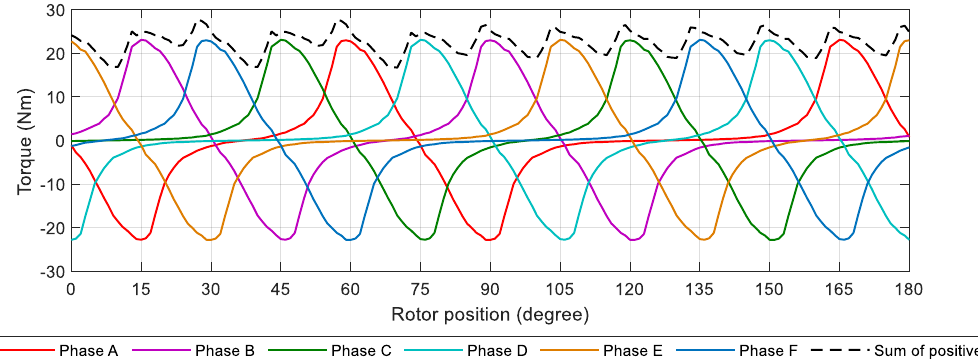
Figure 10. Static characteristics of the proposed SRM from FEM simulation results.